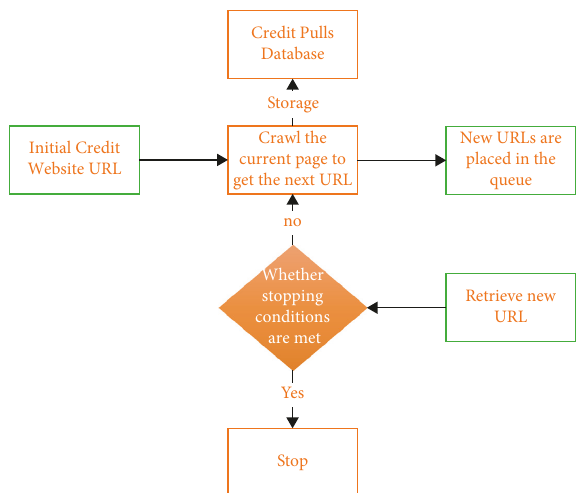
Figure 2: Implementation of web crawler in credit